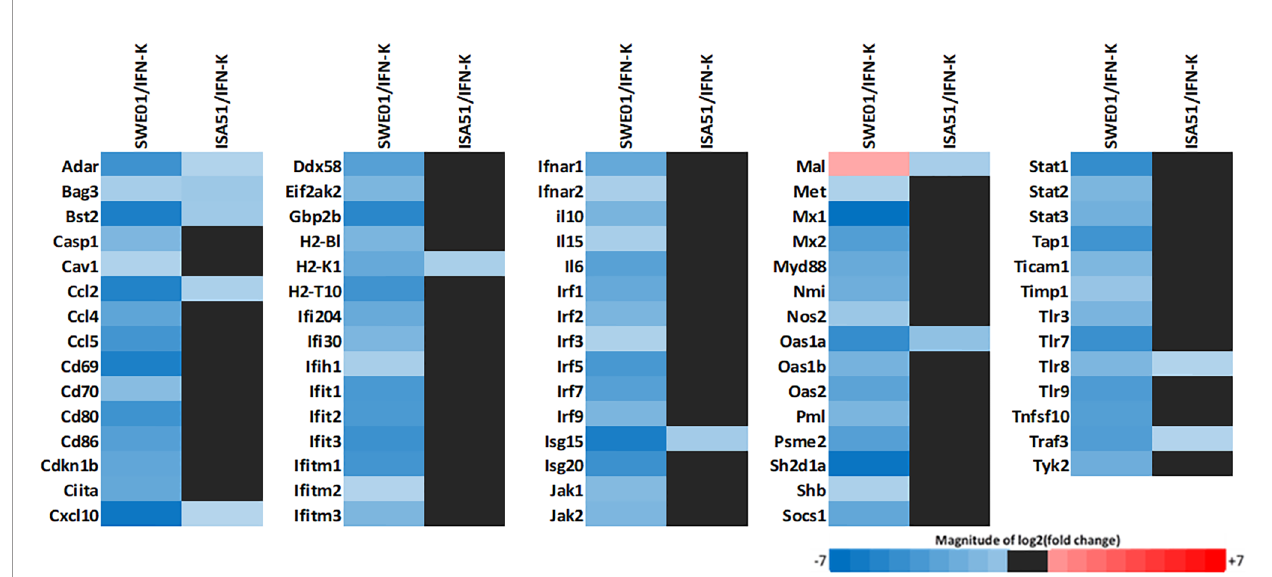
FIGURE 2 | Type 1 IFNs signature. Mandibular lymph nodes were isolated in all living mice (n=14 in SWE01-adjuvanted control mice, n=6 in SWE01/IFN-K mice, n=18 in ISA51-adjuvanted control mice and n=7 in ISA51/IFN-K mice) at sacri fi ce (D+122) to determine the expression pro fi le of type 1 IFNs pathways genes (type 1 IFN signature). Fold changes were determined using the DD CT method, with a cut off of 2, and compared between IFN-K-treated mice (SWE01/IFN-K and ISA51/ IFN-K) and their controls (not treated, PBS and KLH